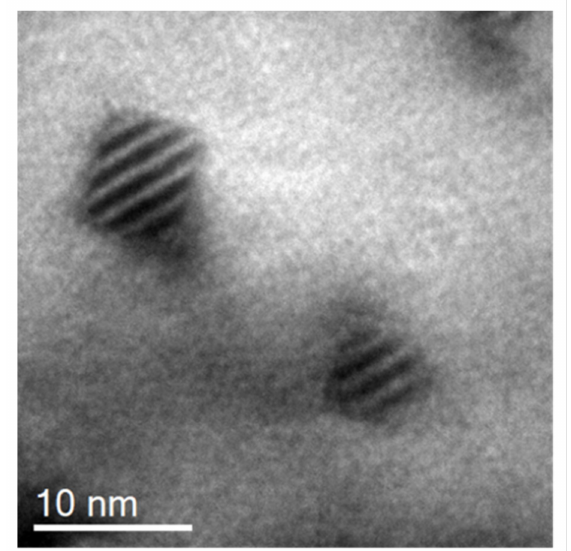
Figure 8. TEM image of two cubical pyrochlore oxides after coarsening at 1300 ◦